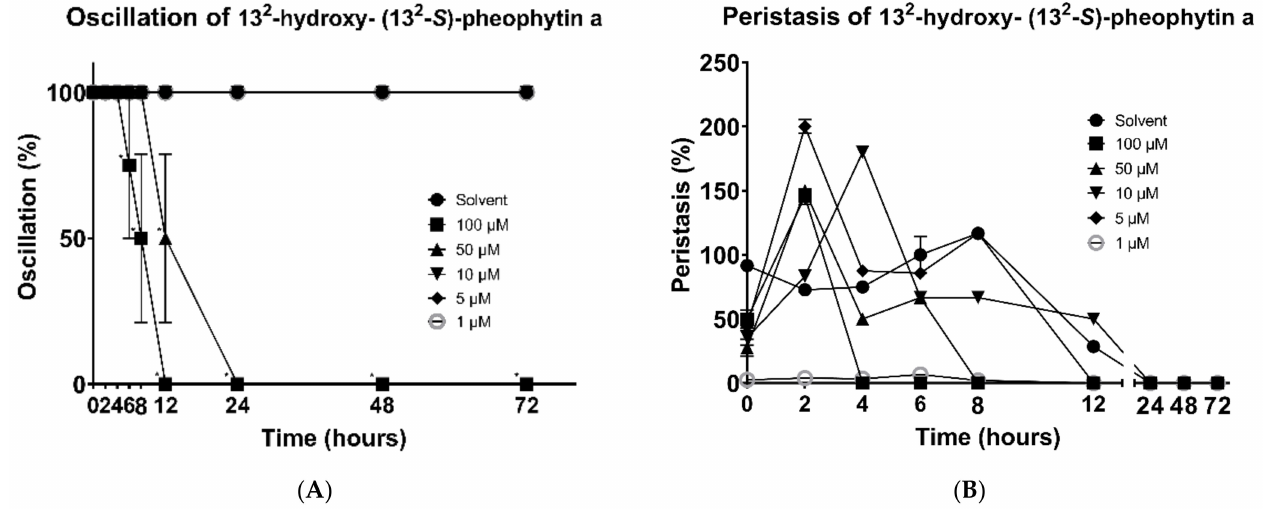
Figure 3. Effects of 13 2 -hydroxy-(13 2 -S)-pheophytin a on H. nana . Treatment with various concentra- tions of 13 2 -hydroxy-(13 2 -S)-pheophytin a (1, 5, 10, 50, and 100 µ M), with incubation times of 2, 4, 6, 8, 12, 24, 48, and 72 h. Time course of 13 2 -hydroxy-(13 2 -S)-pheophytin a effect on H. nana oscillation ( A ) and peristalsis ( B ) are presented as percentages. Solvent was 0.1% DMSO. Each value is presented as the mean ± SD of three individual experiments; * p < 0.05 indicates a significant difference versus vehicle-treated worms.